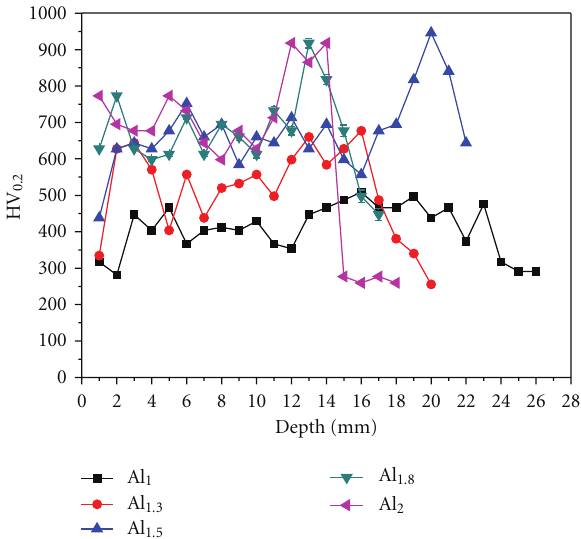
Figure 6: The microhardness distribution in di ff erent X values ( X = 1, 1.3, 1.5, 1.8, and 2.0).